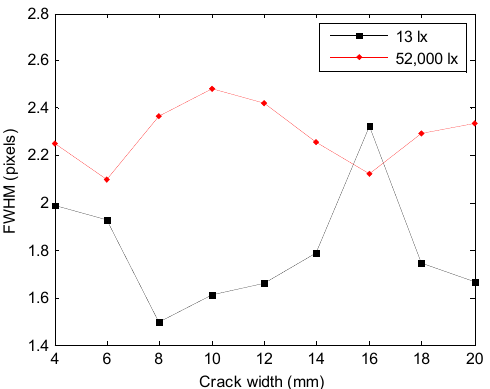
Figure 10. Full width at half maximum (FWHM) of point spread function (PSF) acquired at the boundary line of the crack versus the crack width of the specimen.